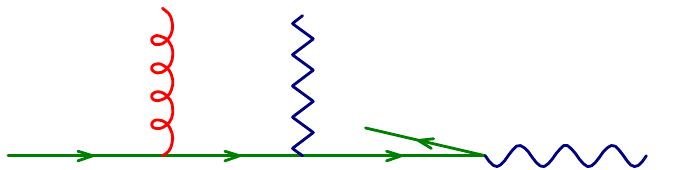
Figure 7 . Configuration that leads to collinear singularities in the qγ → Zqg